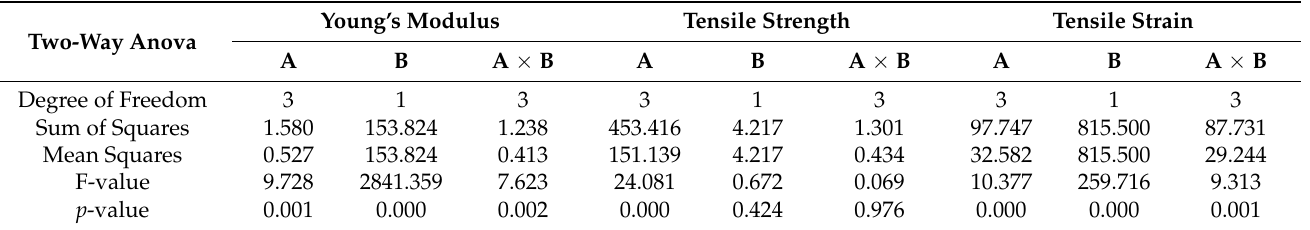
Table 6. Statistical analysis results of various 3D-printed PHB/PUA compositions on tensile